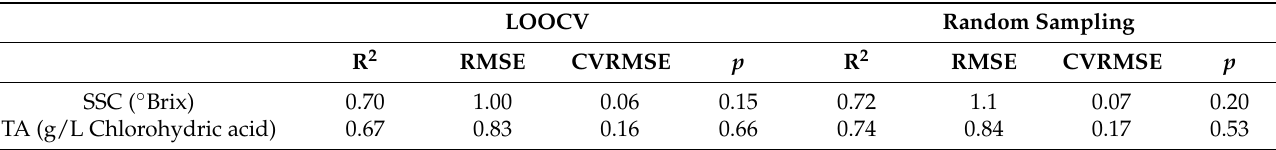
Table 2. R 2 , RMSE, CVRMSE, and p ( p -value from paired samples t -test) between reference values of SSC and TA, measured by chemical methods, and those estimated based on ANN approaches during the LOOCV and random